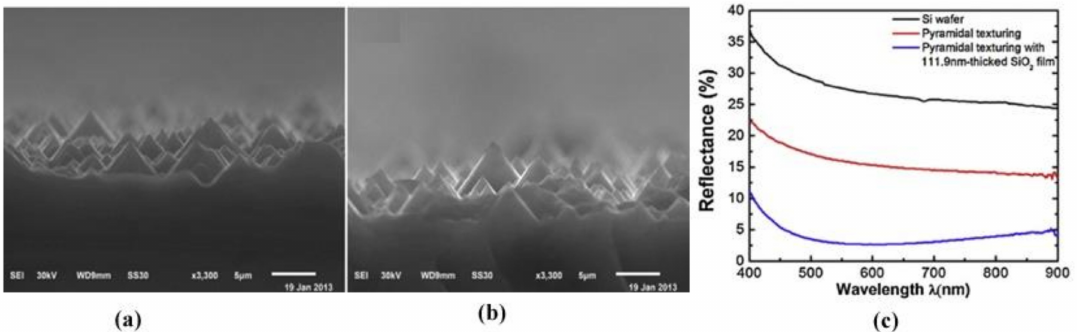
Figure 15. Pyramidal textured SiO 2 surface ( a ) before and ( b ) after thermal oxidation. ( c ) Comparison of reflectance in terms of wavelength for Si wafer surface, pyramidal textured Si surface without and with SiO 2 coating Reprinted with permission [105]; 2015,